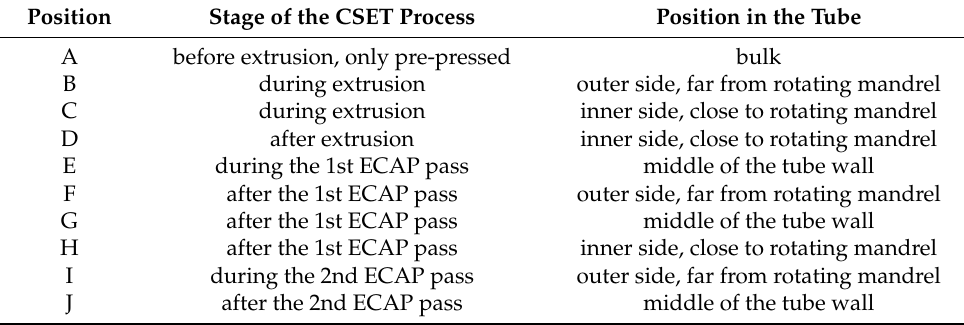
Figure 2. LM figure of the initial state showing ( a ) large elongated grains and ( b ) flow lines visible on the etched surface of the cross-section on the ND plane in the MDZ area after CSET. For the meaning of areas A–J, see the text and Table 1. Table 2. Microstructural parameters (grain width and length, grain aspect ratio, and percentage of Table 1. Positions in the processed sample where the microstructure were HAGBs evaluated from the OIMs in Figure 3) taken from positions denoted in Figure 2.